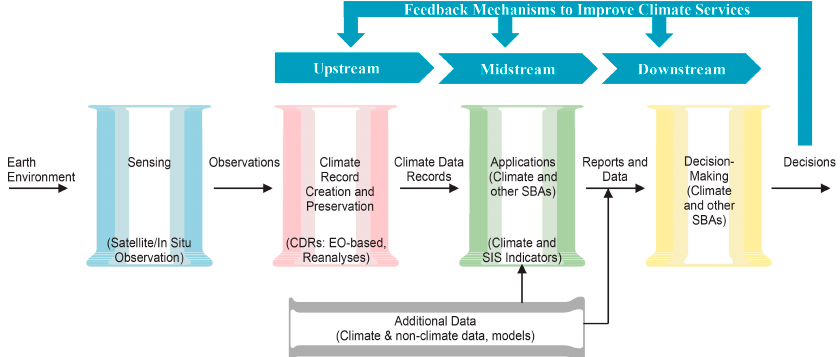
Figure 4. Use cases description following a common template, indicating when facilitated